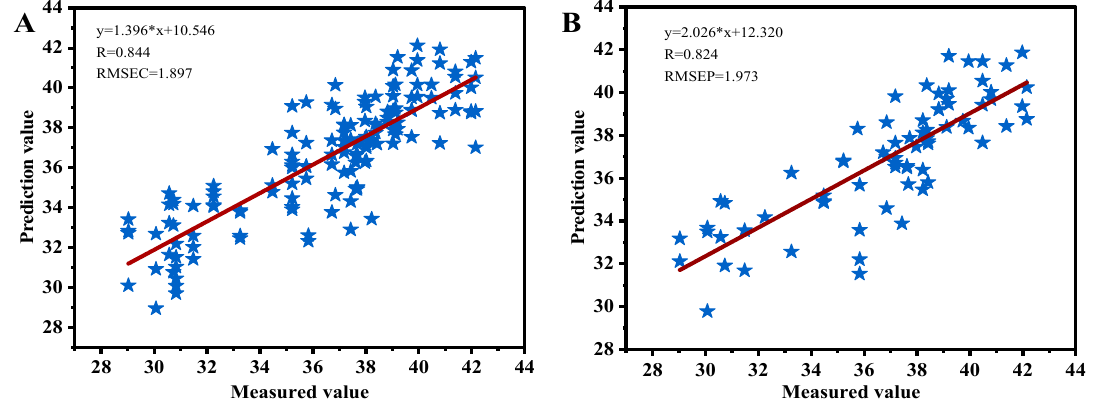
Figure 7. PLSR prediction model of chlorophyll content based on VCPA characteristic wavelength extraction methods: ( A ) is calibration set; ( B ) is prediction set.